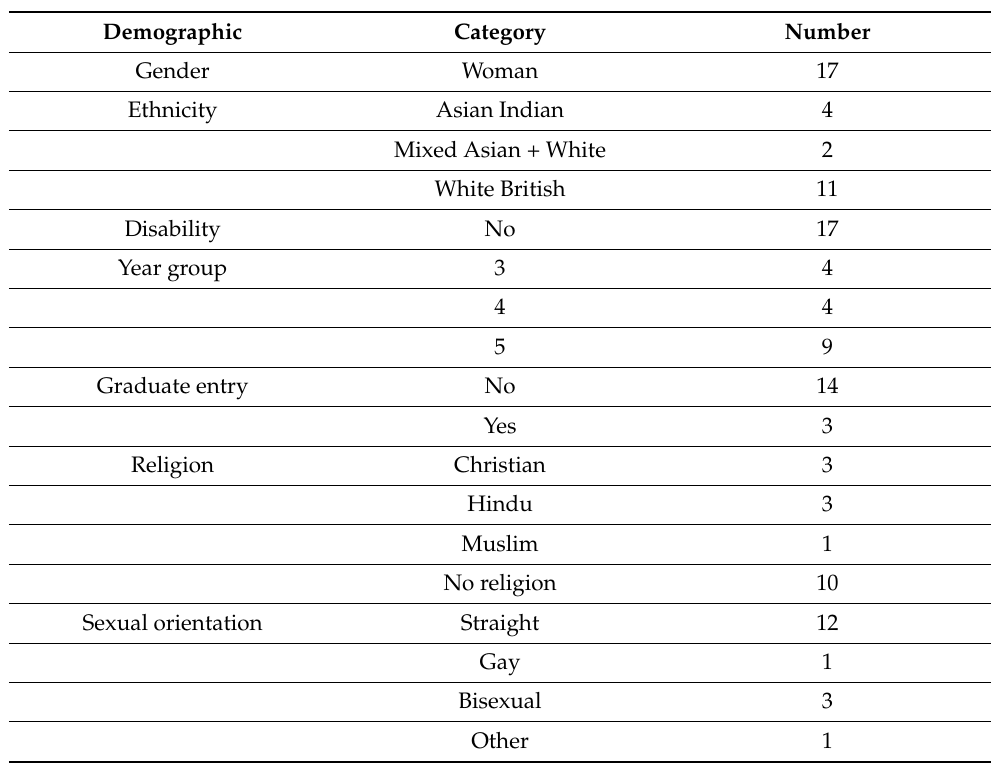
Table 2. Participant Demographic